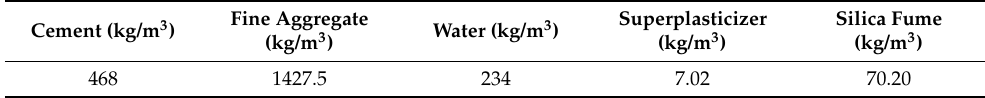
Table 2. Mix proportion and constituents for mortar